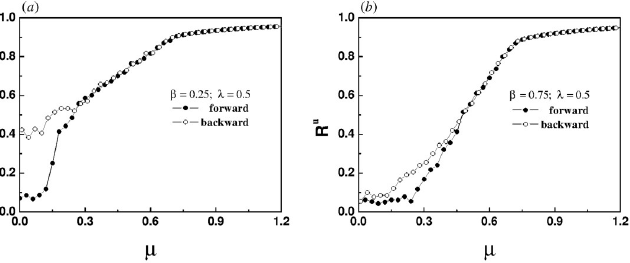
Fig 3. The evolution of order parameter of the upper layer with the increase of intra-layer coupling strength for different values of β , (a) β = 0.25, (b) β = 0.75. The inter-layer coupling strength λ is set to 0.5. Every data point in the two panels is the average of 2000 time steps after discarding the initial 2000 time